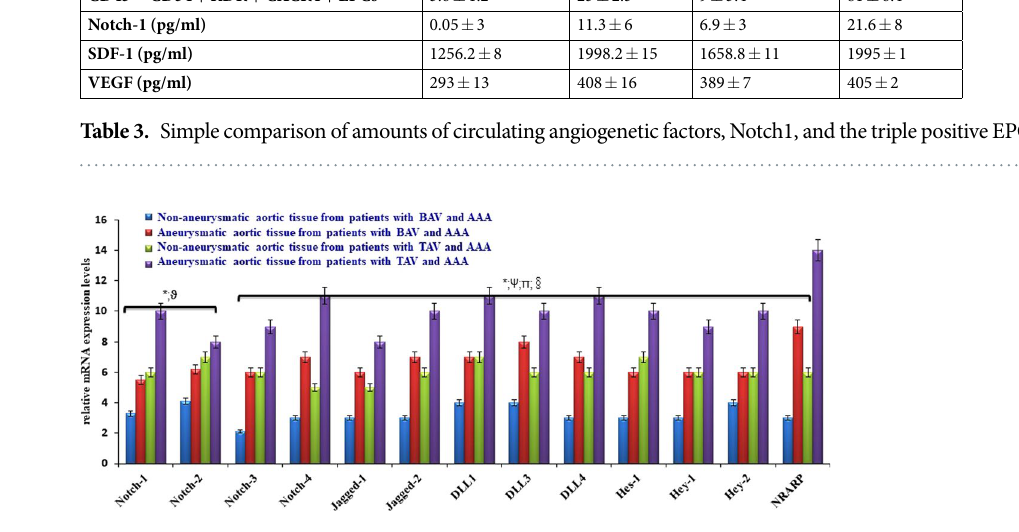
Figure 3. Expression levels of Notch signaling in aortic aneurysms. Significant differences were observed among the groups with the lowest levels detected in BAV groups than TAV cases and controls (see details in Result section). The statistical significance was tested as it follows: aneurysmatic aortic tissue from patients with BAV and AAA vs. aneurysmatic aortic tissue from patients with TAV and AAA ( * P < 0.001); non-aneurysmatic aortic tissue from patients with TAV and AAA vs. aneurysmatic aortic tissue from patients with TAV and AAA( ϑ P < 0.05); non-aneurysmatic aortic tissue from patients with TAV and AAA vs. aneurysmatic aortic tissue from patients with TAV and AAA ( ψ P < 0.001); non-aneurysmatic aortic tissue from patients with BAV and AAA vs. aneurysmatic aortic tissue from patients with BAV and AAA ( § P < 0.001); non-aneurysmatic aortic tissue from patients with BAV and AAA vs. non-aneurysmatic aortic tissue from patients with TAV and AAA ( π P <